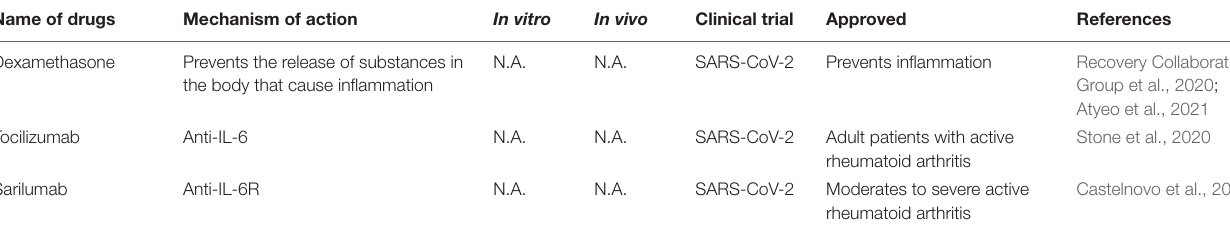
TABLE 5 | Representative therapeutic antibodies strategies for CoV infections. Name of